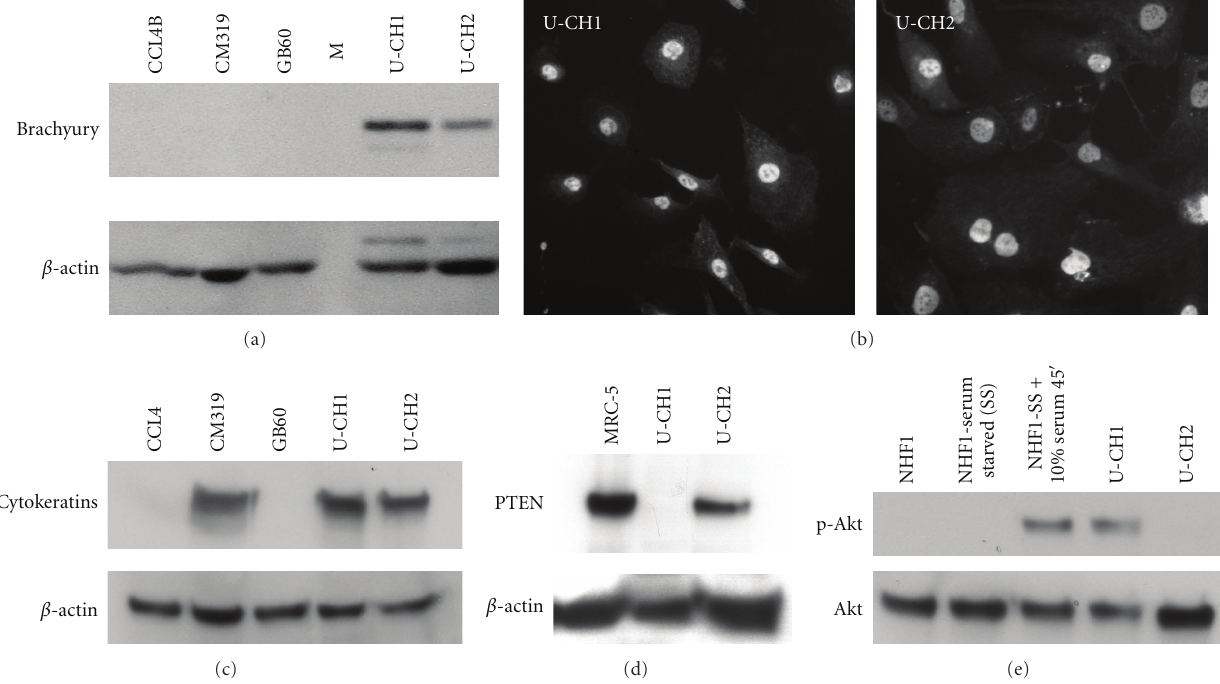
Figure 4: Brachyury expression in putative chordoma cell lines. (a) Immunoblot analysis of Brachyury of CCL4B, CM319, GB60, U-CH1, and U-CH2 cells reveals significantexpression of the ∼ 50kDa Brachyury protein only in U-CH1 and U-CH2 cells. Molecular weight standard lane is denoted by M. (b) Immunofluorescent staining for Brachyury revealed nuclear localizationof the protein in both U-CH1 and U-CH2. (c) Immunoblot analysis of cytokeratin protein expression in CCL4, CM319, GB60, U-CH1, and U-CH2. (d) Immunoblot analysis of PTEN protein expression in MRC-5 primary human fibroblasts, U-CH1 and U-CH2. (e) Immunoblot analysis of activation of Akt in normal human fibroblasts (growing, serum starved for 48 hours then with, or without, 10% added serum for 45 minutes), U-CH1 and U-CH2. Phospho-Akt- (Serine 473-) specific antibodies show Akt activation while similar protein loading was confirmed by staining for total Akt protein levels. For A, C, and E similar protein loading was confirmed by staining for β